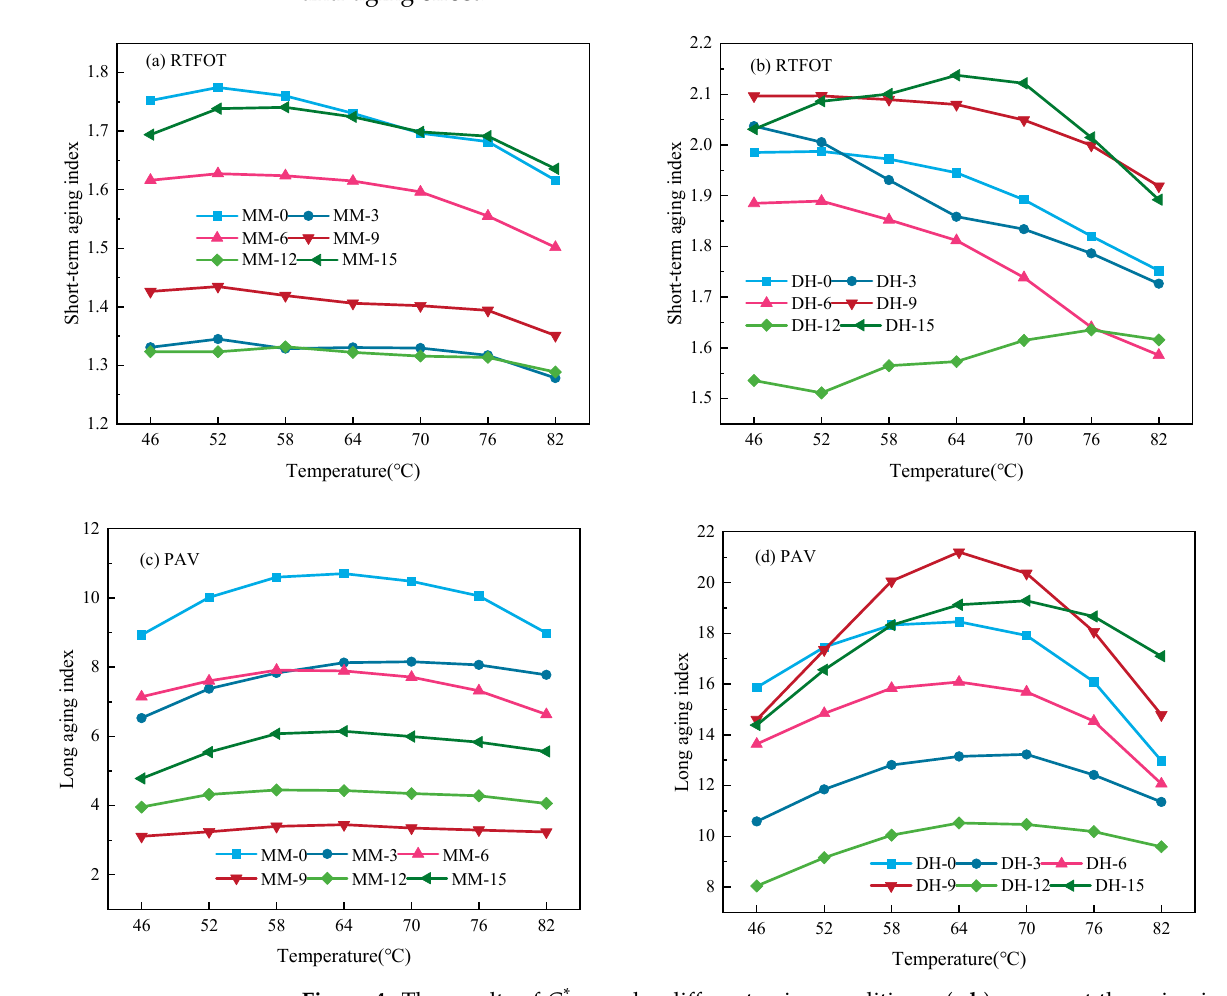
Figure 4. The results of G * AI under different aging conditions. ( a , b ) represent the aging index of different asphalt with short-term aging, ( c , d ) represent the aging index of different asphalt with long-term aging.